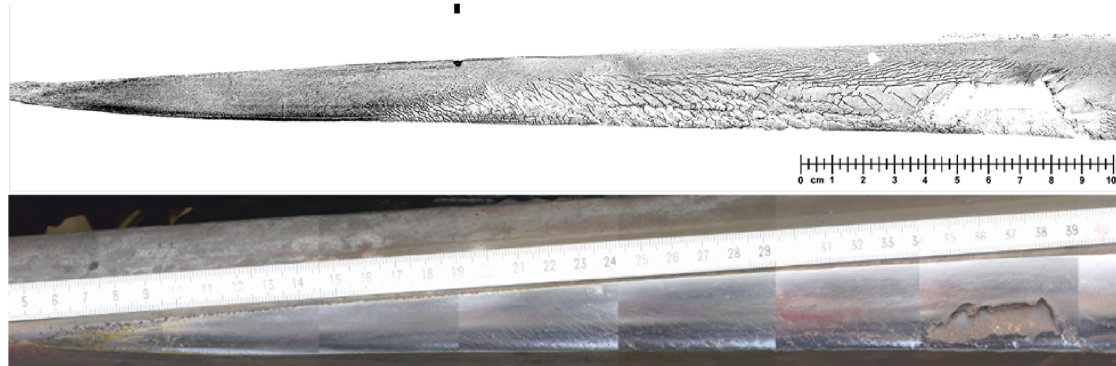
Fig. 4 MPI (above) and HRPI (below) images of the rolling surface on a frog nose after 52